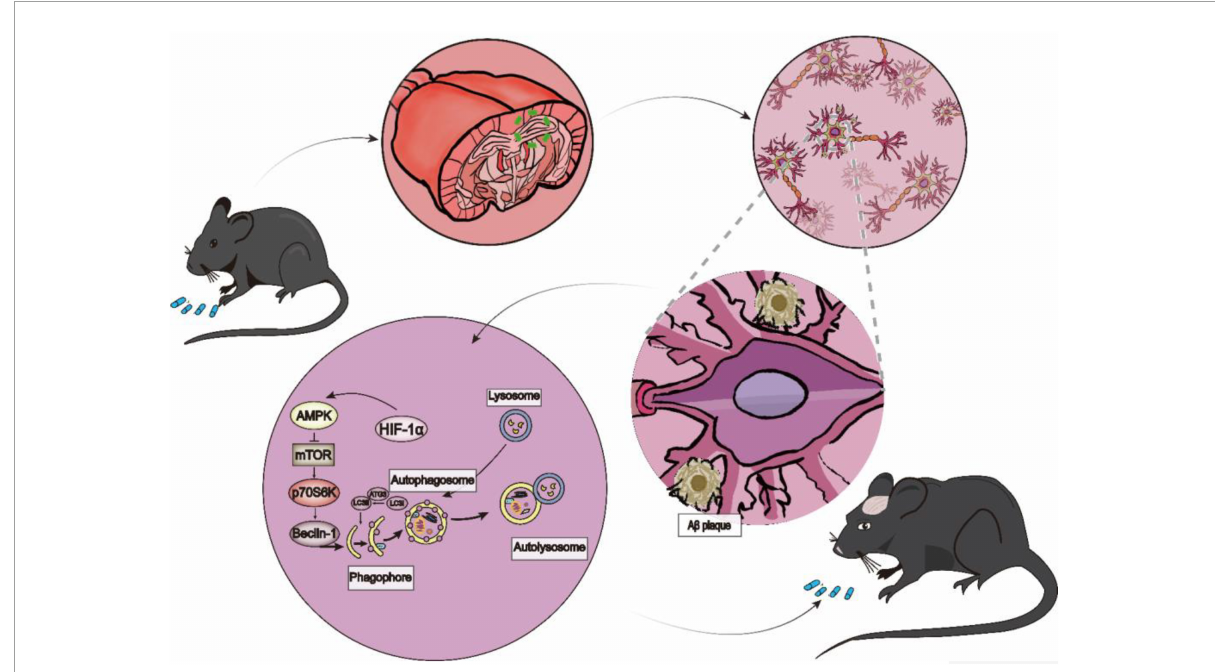
FIGURE9 The Process and Regulation of Autophagy. A long-term HFD influenced brain damage by upregulating the expression of HIF-1 α , which inhibited autophagy by inhibiting the expression of p-AMPK/p-mTOR/P70S6K and promoting the expression of p62. Meanwhile, HFD increased the protein level of A β 42